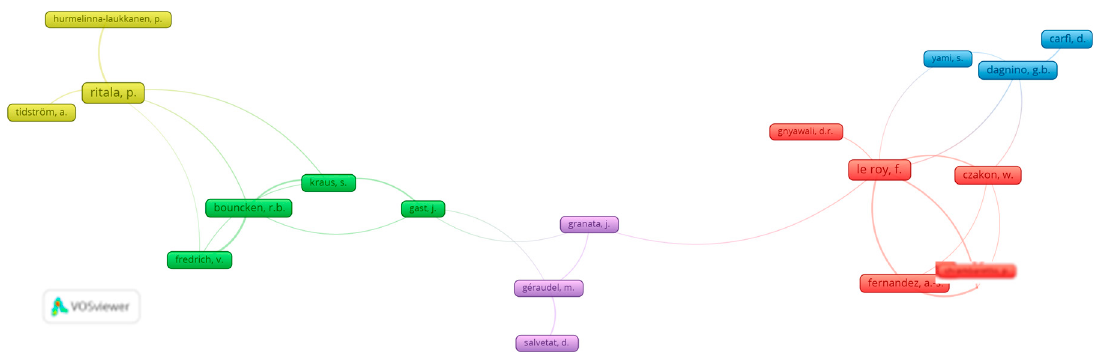
Figure 5. VOSviewer visualization of the TOP-18 most cited authors in the area of coopetition research (1.6.10 version), N = 664 papers, where 5 clusters or scientific schools are identified (the color means the same cluster, where authors cited each other and are strongly related).